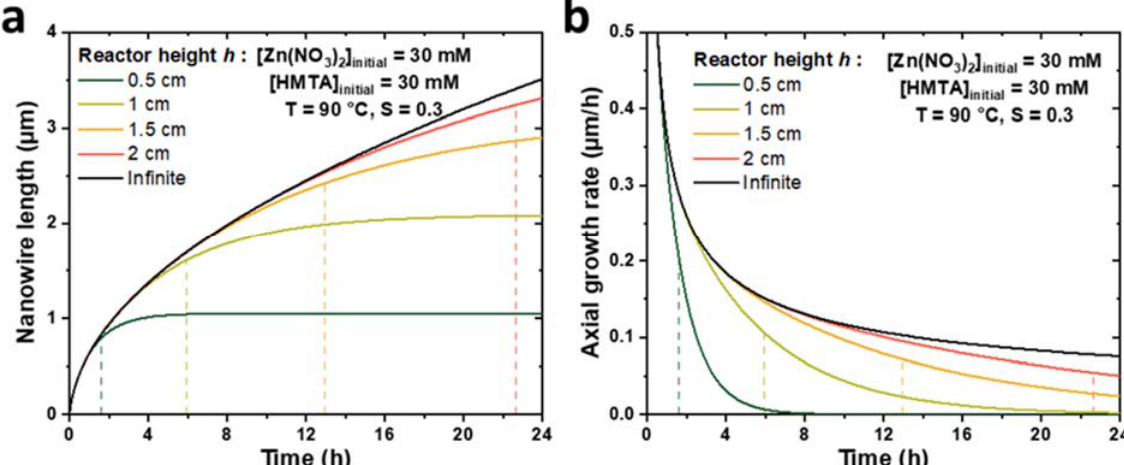
Figure 2. Theoretical evolutions of ( a ) the length and ( b ) the axial growth rate with the effective growth time of ZnO NWs for different reactor heights, h . For h values ranging from 0.5 to 2 cm (colored lines), the curves are determined by the numerical approach detailed in this work, whereas for an infinite h value (black lines), the curves are determined by Equations (2) and (3) (taken from [33]). The dashed lines represent the effective growth time t h (taken at α = Δ L/L = 5%, see text) for each reactor height, h, considered. The values taken for the different parameters correspond to typical growth at 90 °C with 30 mM of Zn (NO 3 ) 2 and HMTA (as determined in [33]), i.e., C 0 = 19.1 mM, C eq = 15.2 mM, k 1 = 18.2 μ m/s, S = 0.3, D = 2.74 × 10 − 9 m 2 /s, and ρ = 4.20 × 10 28 m − 3 .